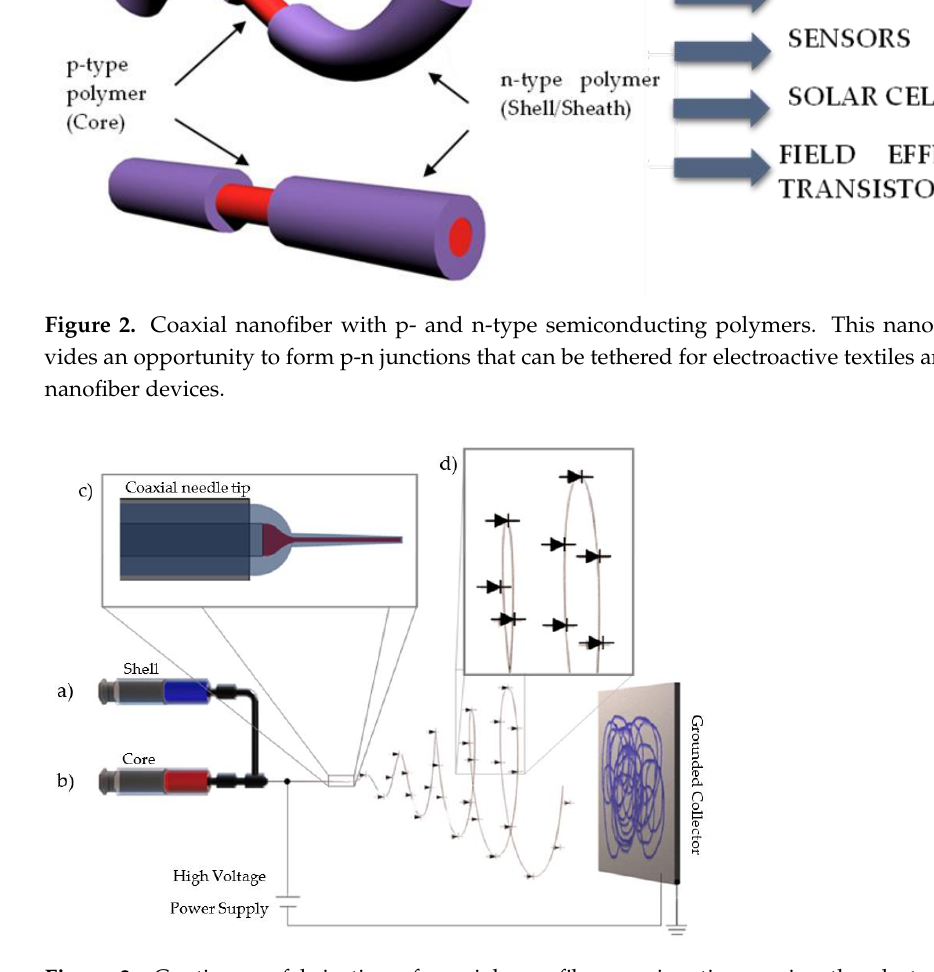
Figure 3. Continuous fabrication of coaxial nanofiber p – n junctions, using the electrospinning technique. The BBL solution ( a , blue) forms the shell/sheath, and the P3HT/PS solution ( b , red) forms the core. An electric field overcomes the surface tension, stretching the solution and forming nanofibers. Inset: ( c ) The coaxial needle tip and magnification ( d ) after the Taylor cone formation, with the diode symbols representing the continuous heterojunction formed between the core and the shell.